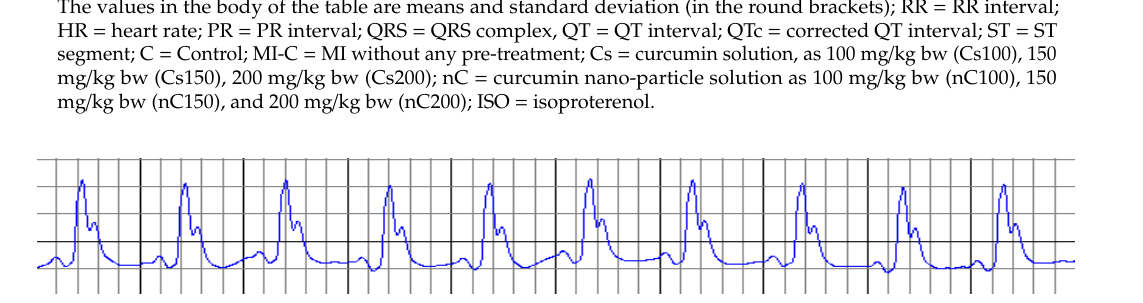
Figure 1. ECG record on day 0, at the beginning of the experiment. Table 3. ECG characteristics by group before isoproterenol (ISO) administration.